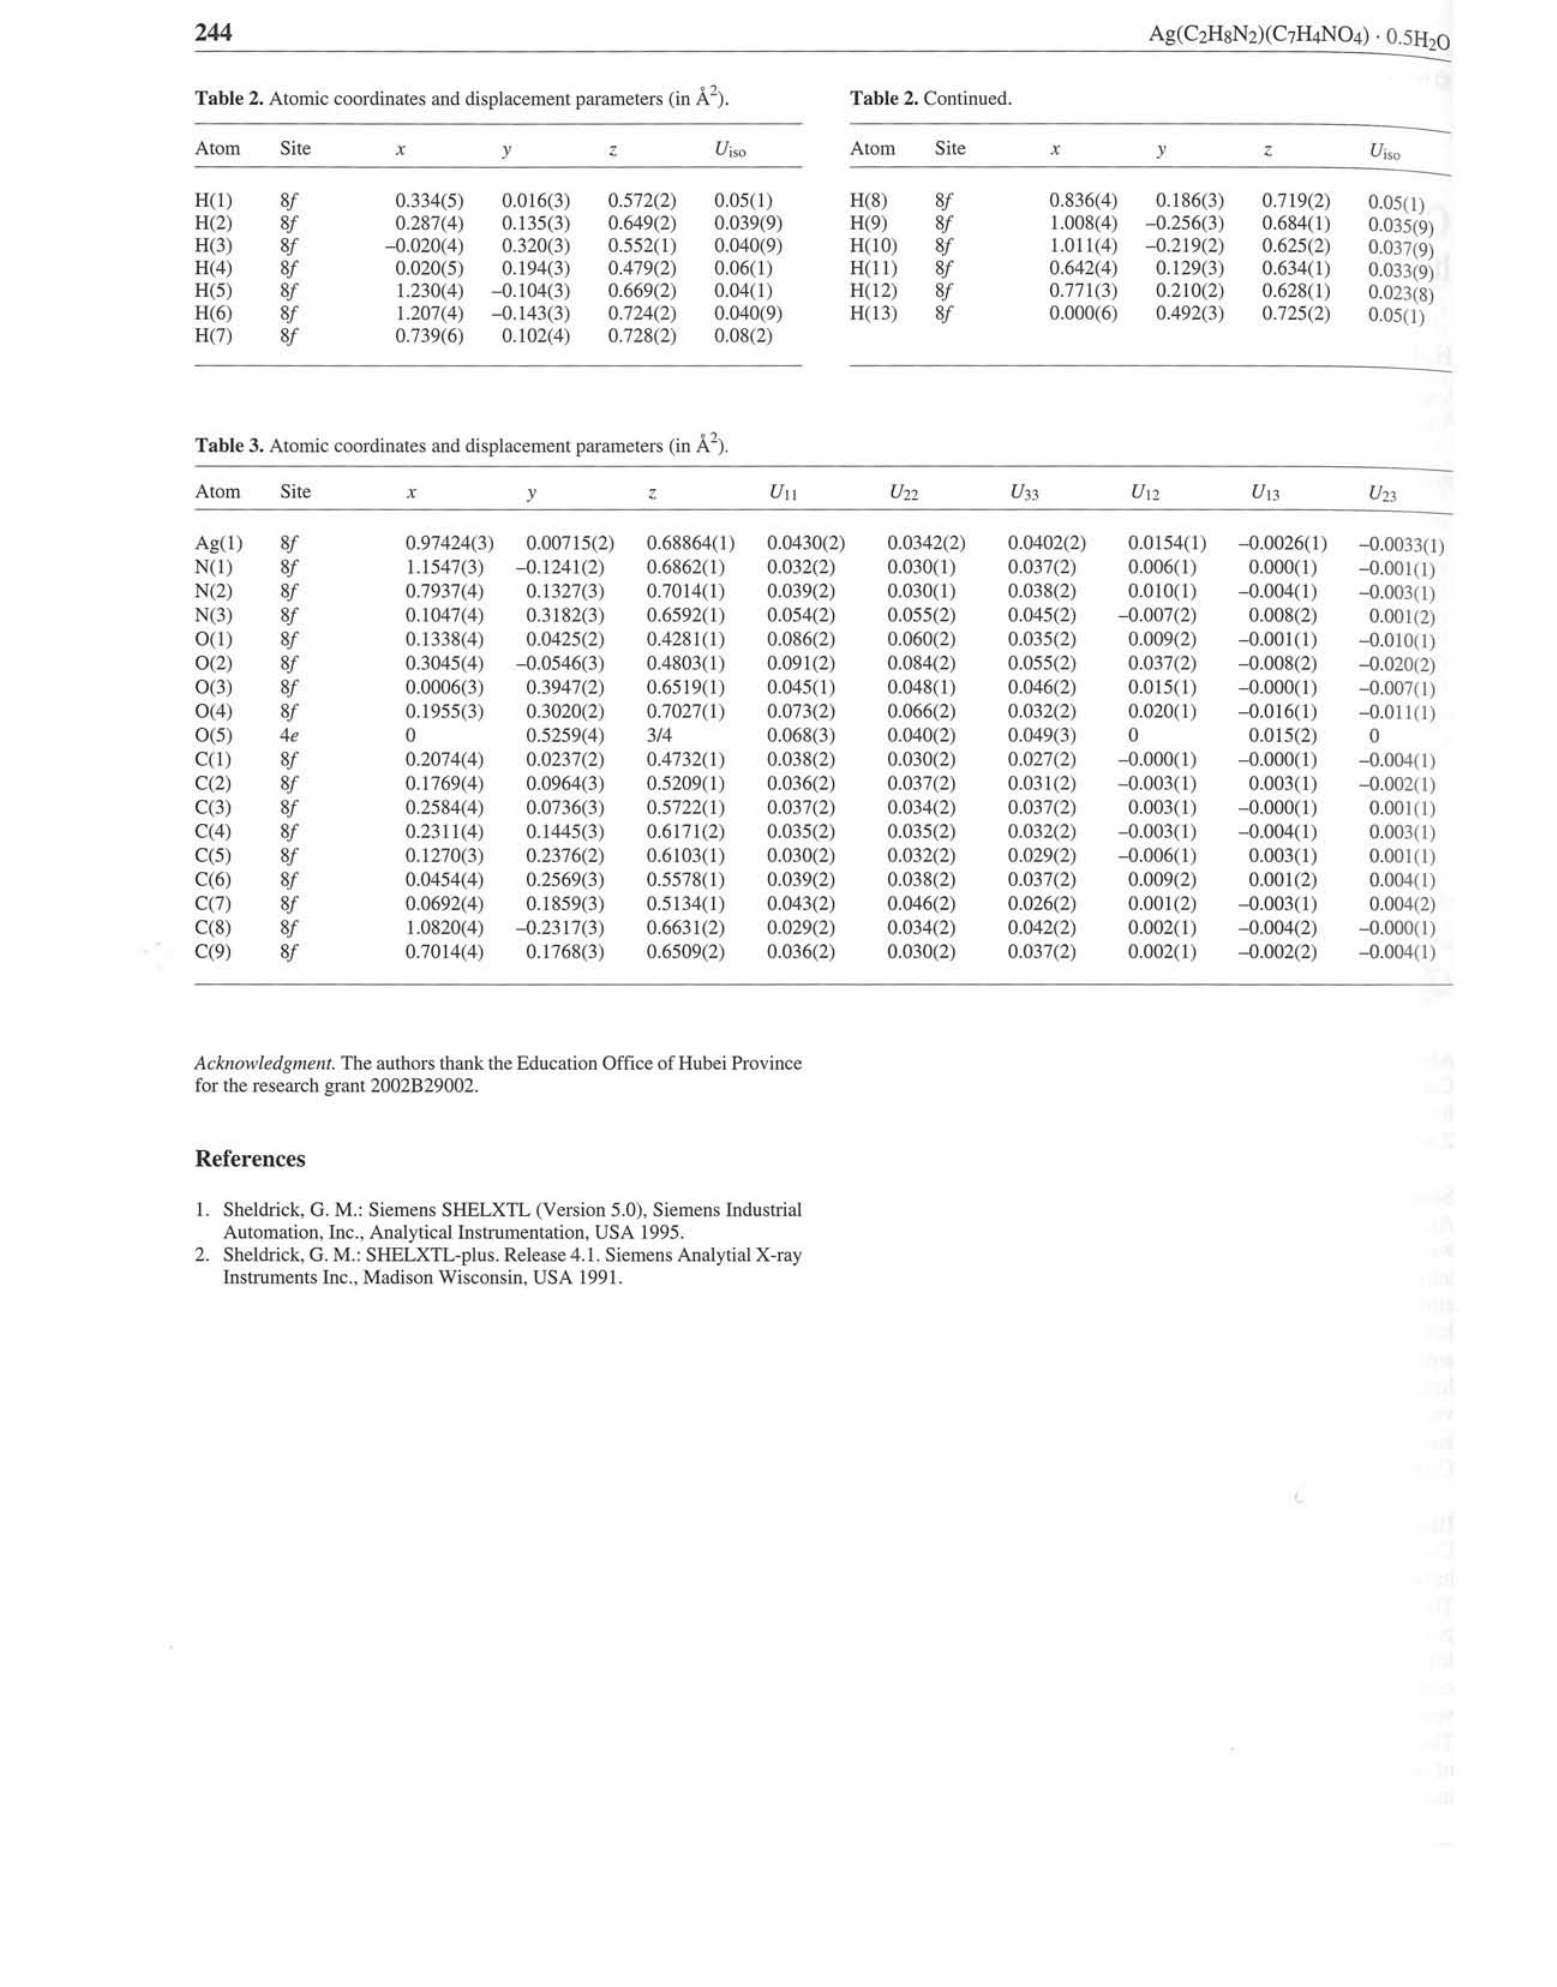
Table 2. Atomic coordinates and displacement parameters (in Â 2 ).